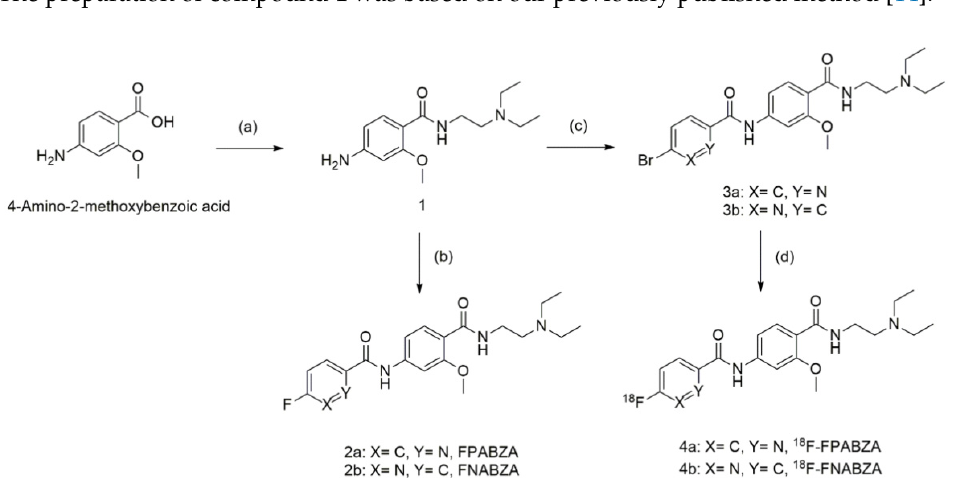
Figure 7. Synthetic scheme of the precursors (2a/2b), radiofluorinated probes (3a/3b), and authentic compounds (4a/4b). Reaction conditions: (a) DEDA, HOBt, EDC, K 2 CO 3 , DIPEA, and DEDA in anhydrous THF, ambient temperature for 16 h; (b) 5-fluoropyridine-2-carboxylic acid/6-fluoronicotinic acid, thionyl chloride, and K 2 CO 3 in anhydrous THF, ambient temperature for 16 h; (c) 5-bromopicolinic acid/6-bromonicotinic acid, thionyl chloride, and K 2 CO 3 in anhydrous THF, thylformamide, 140 °C for 30 min.